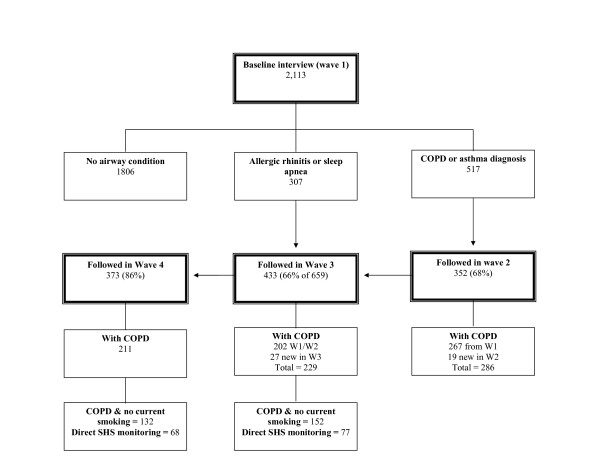
Details of sampling and recruitment for baseline through wave 4. Wave 2 attempted to recruit all subjects who indicated a diagnosis of asthma or COPD at baseline. Wave 3 attempted to recruit all subjects followed in wave 2 plus those who indicated a diagnosis of allergic rhinitis or obstructive sleep apnea at baseline. Wave 4 attempted to recruit subjects who completed wave 3 follow-up.